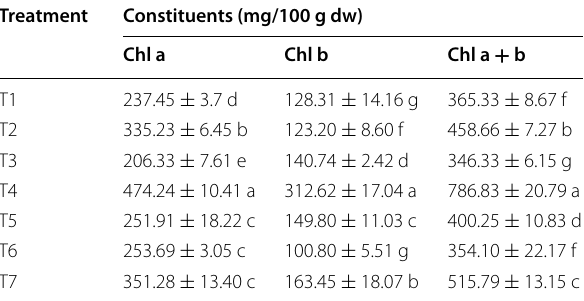
Chl a chlorophyll A, Chl b chlorophyll B, Chl a